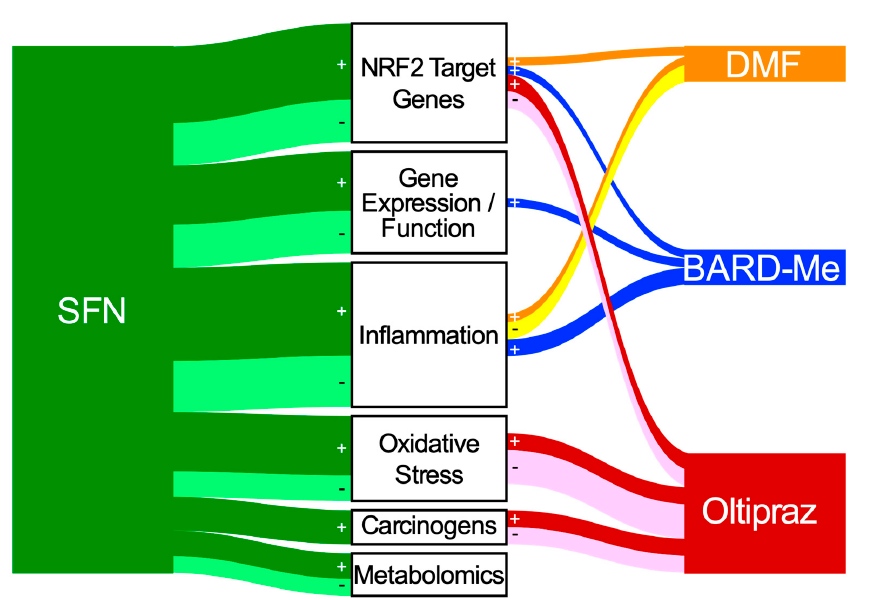
Figure 5. Sankey diagram of mechanism-based biomarkers measured in clinical trials for SFN (green), DMF (orange), BARD-Me (blue), and oltipraz (red). Darker lines (green, orange, blue, red) marked with “ + ” are studies in which at least 1 biomarker was reported to exhibit a statistically significant ( p < 0.05) change. Lighter lines marked with “-“ indicate nonsignificant (i.e., null) responses for all biomarkers examined within a study. This accounting overemphasizes positive outcomes. Lines emanating from each inducer are connected to di ff erent measured biomarker categories. The box height for each NRF2 categories are proportional to the number of biomarker category